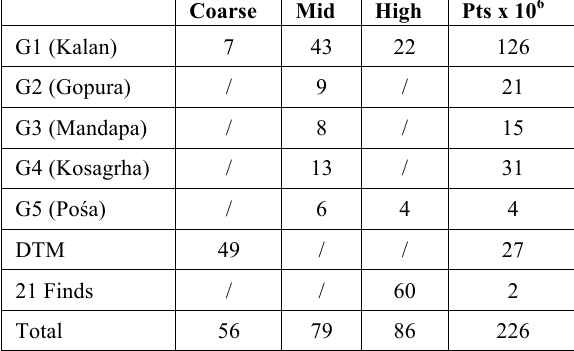
Table 2. Point clouds acquired at different resolution